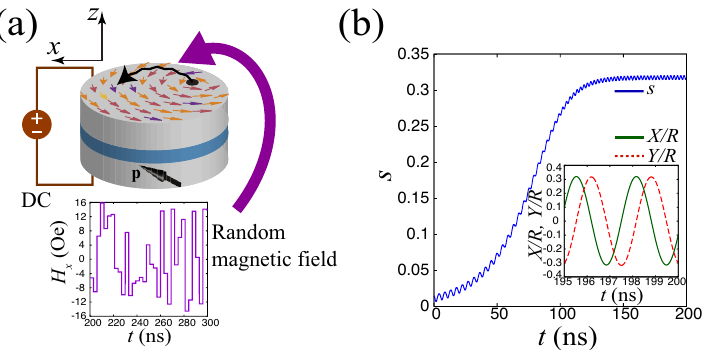
Figure 1. ( a ) Schematic illustration of vortex spin torque oscillator and dynamics of the vortex core induced by a direct current (DC) and random magnetic field. The DC induces an oscillation of the vortex core around the disk center whereas the random magnetic field modulates the oscillation amplitude. ( b ) Evolution of the normalized amplitude s in the presence of the current I = 5 mA. The inset shows the dynamics of the x component and y component of the magnetic vortex core normalized by the radius of the magnetic vortex